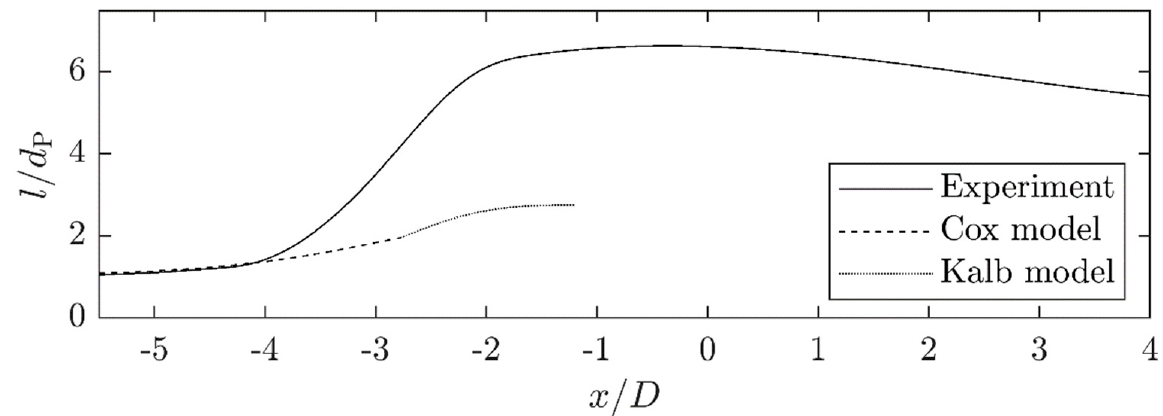
Figure 17. Comparison of the drop aspect ratio development when passing through the orifice between the exper- imental measurement and the numerical simulation according to the Cox or Kalb model for a high viscosity drop ( λ exp = 10.8/ λ num = 10.5) at a Reynolds number of Re = 4000 .